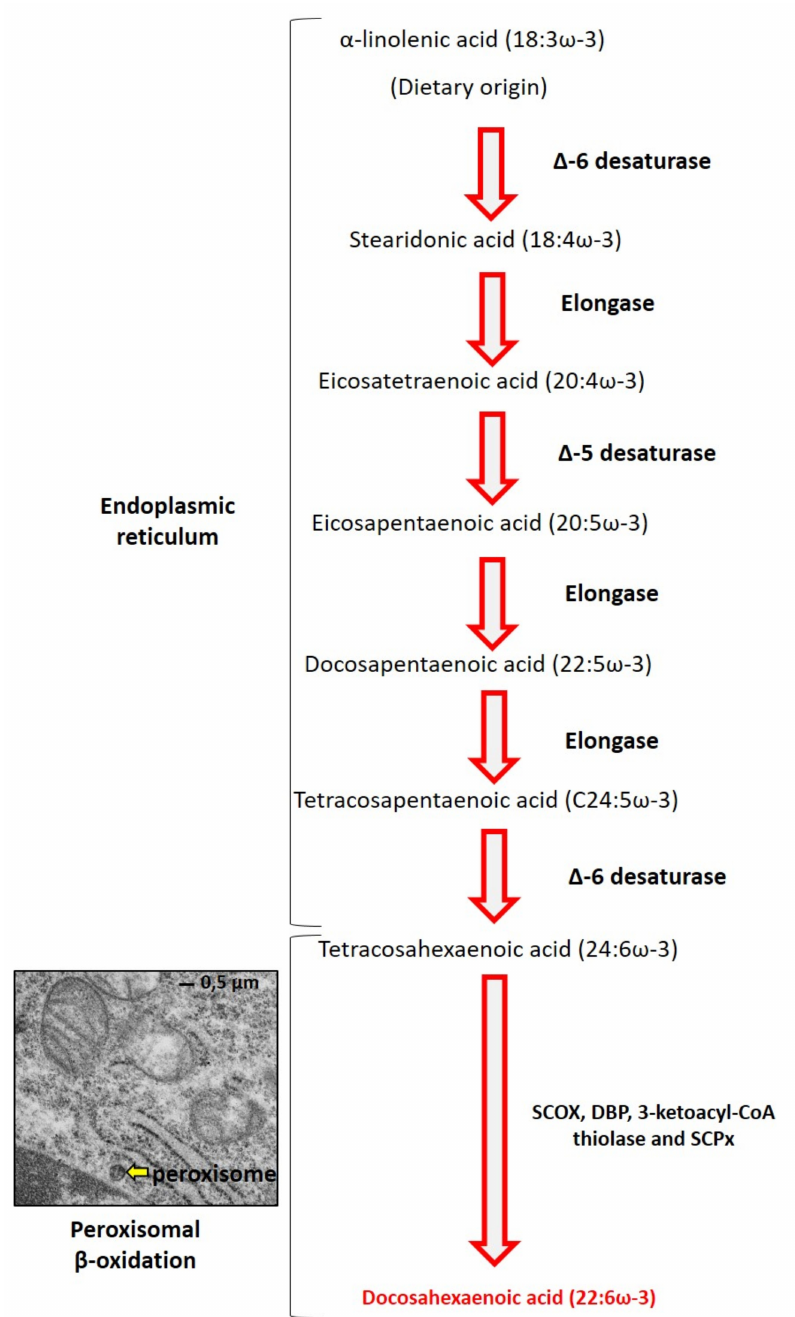
Figure 2. Biochemical pathway of DHA biosynthesis. In the endoplasmic reticulum, α -linolenic acid is converted to tetracosahexaenoic acid by the action of elongases and desaturases. Then, in the peroxisome (yellow arrow: electron microscopy of C2C12 myoblasts; provided by Imen Ghzaiel, PhD student), β -oxidation occurs and leads to the synthesis of